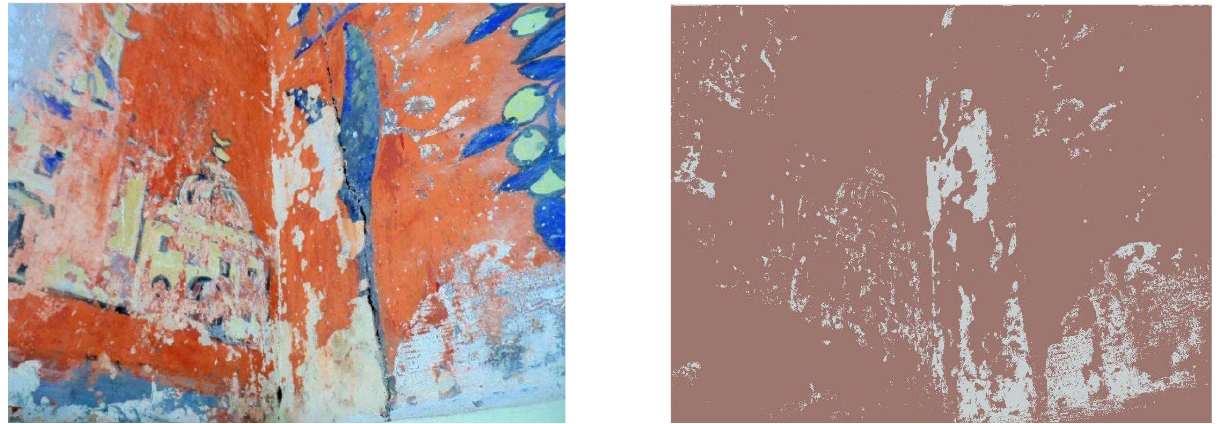
Table 1. Number of registered pixels for each class and the calculated of the mean values of each color channel (red, green, and blue).